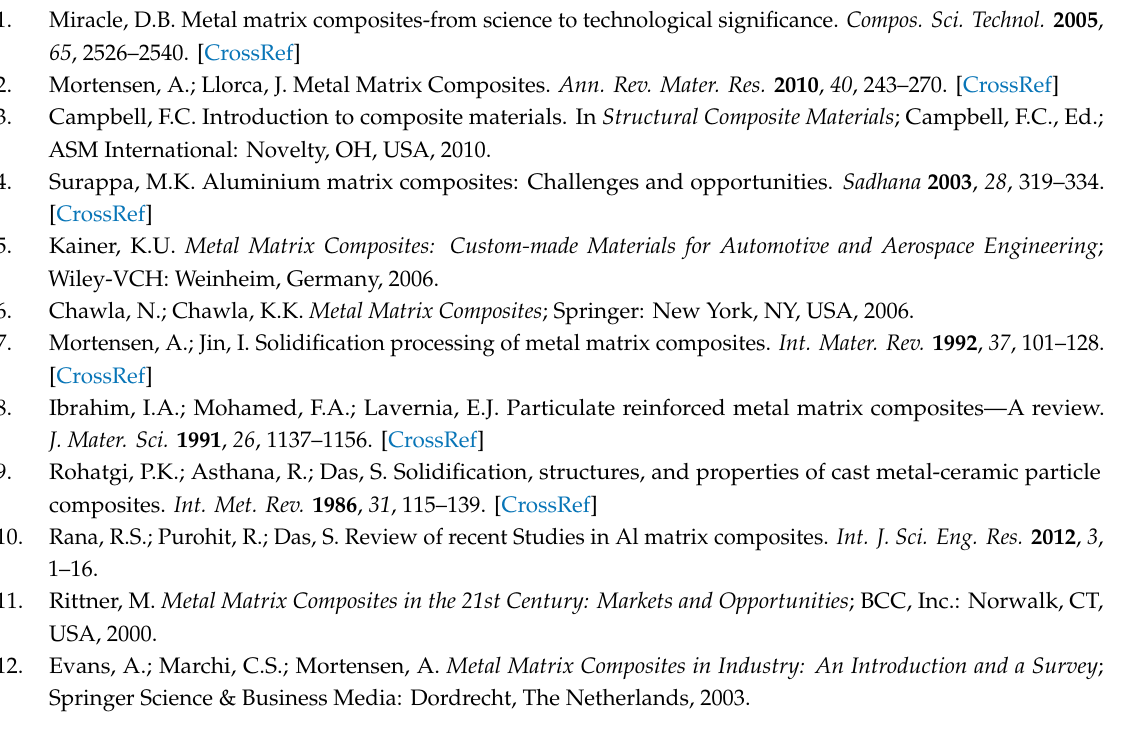
Figure S1: XRD patterns of the 20 vol.% SiC / 6061Al powder beds held at 650 ◦ C for various